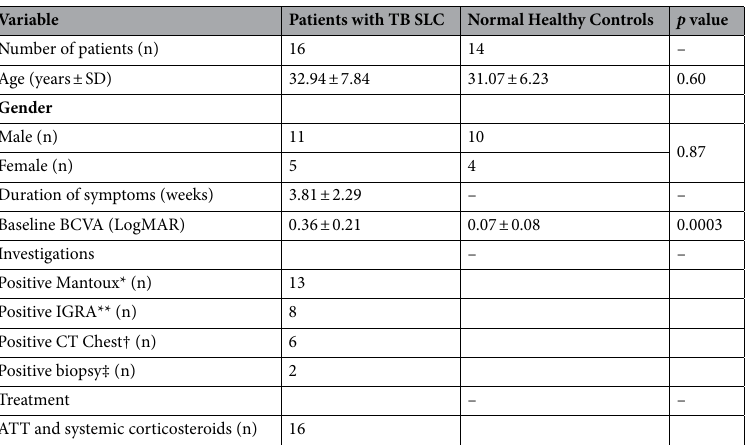
Table 1. Demographic and clinical characteristics of patients with tubercular serpiginous-like choroiditis and normal healthy control subjects included in the study. *Indicates induration ≥ 10 mm × 10 mm by tuberculin skin test after 48–72 h. **Indicates a positive interferon gamma assay (IGRA) using QuantiFERON TB Gold® test. † Indicates evidence of healed or active tuberculosis on computerized chest tomography. ‡ Indicates biopsy from lung/lymph nodes, or minor salivary glands.